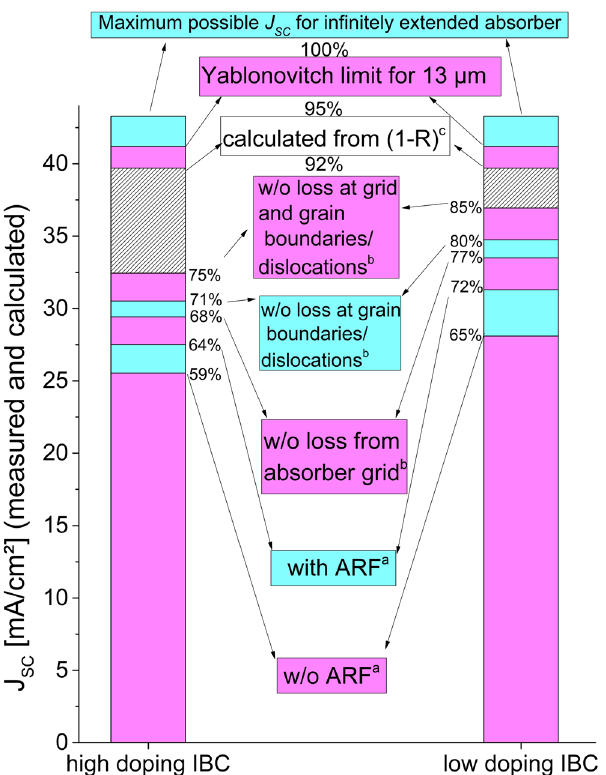
Figure 5. Current loss analysis for the best highly and lowly doped IBC cells. ( a ) Measured by solar simulator. ( b ) Measured J SC values corrected with calculated loss fractions due to current collection inhomogeneities obtained from LBIC measurements. ( c ) Measured by UV/VIS spectrometer. Rest: calculated from literature data. Hatched areas: loss by bulk and interface recombination and parasitic